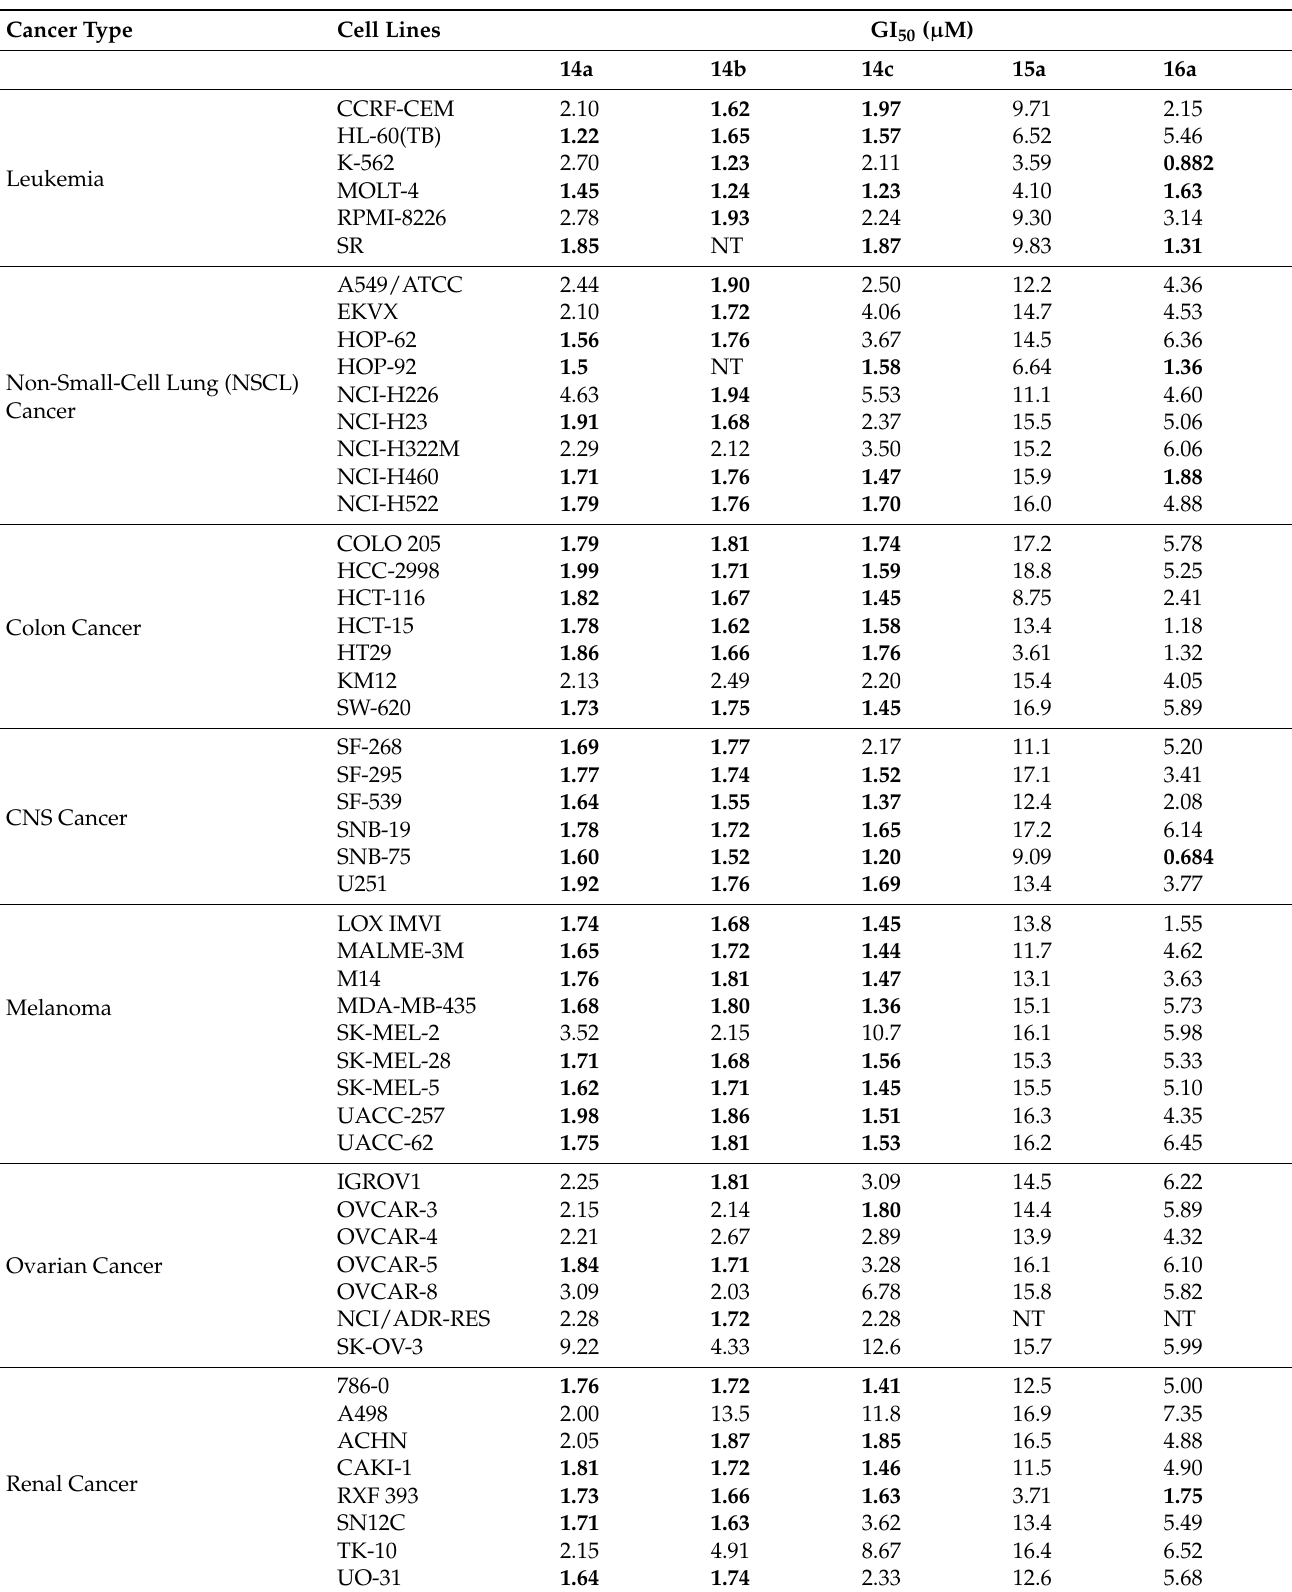
Table 3. GI 50 ( µ M) of compounds 14a–c , 15a and 16a against NCI-60 human tumor cell lines in five-dose test a,b